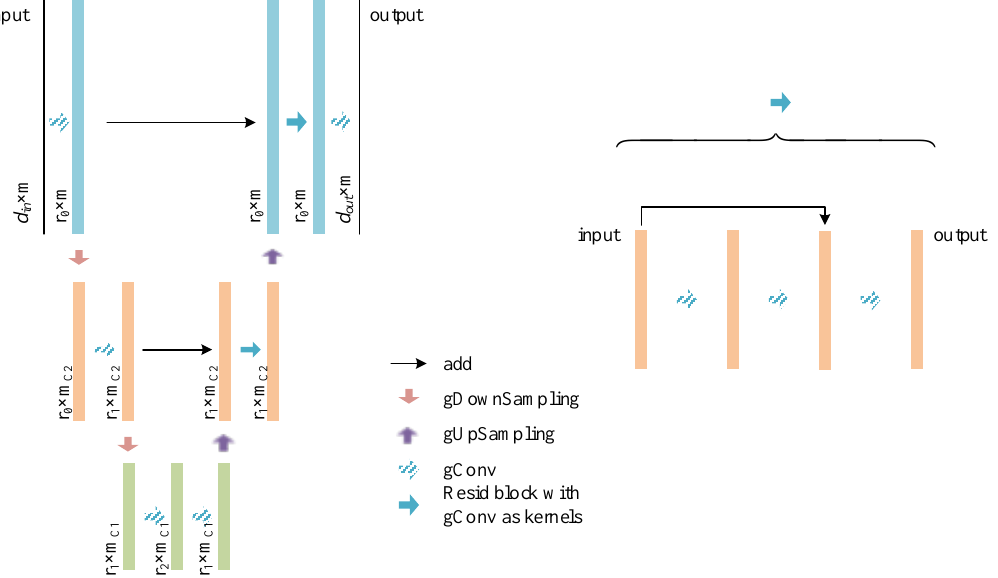
Figure 5. On the left is the architecture of a single Unet branch; on the right is the unfolded format of the resid block with gConv as